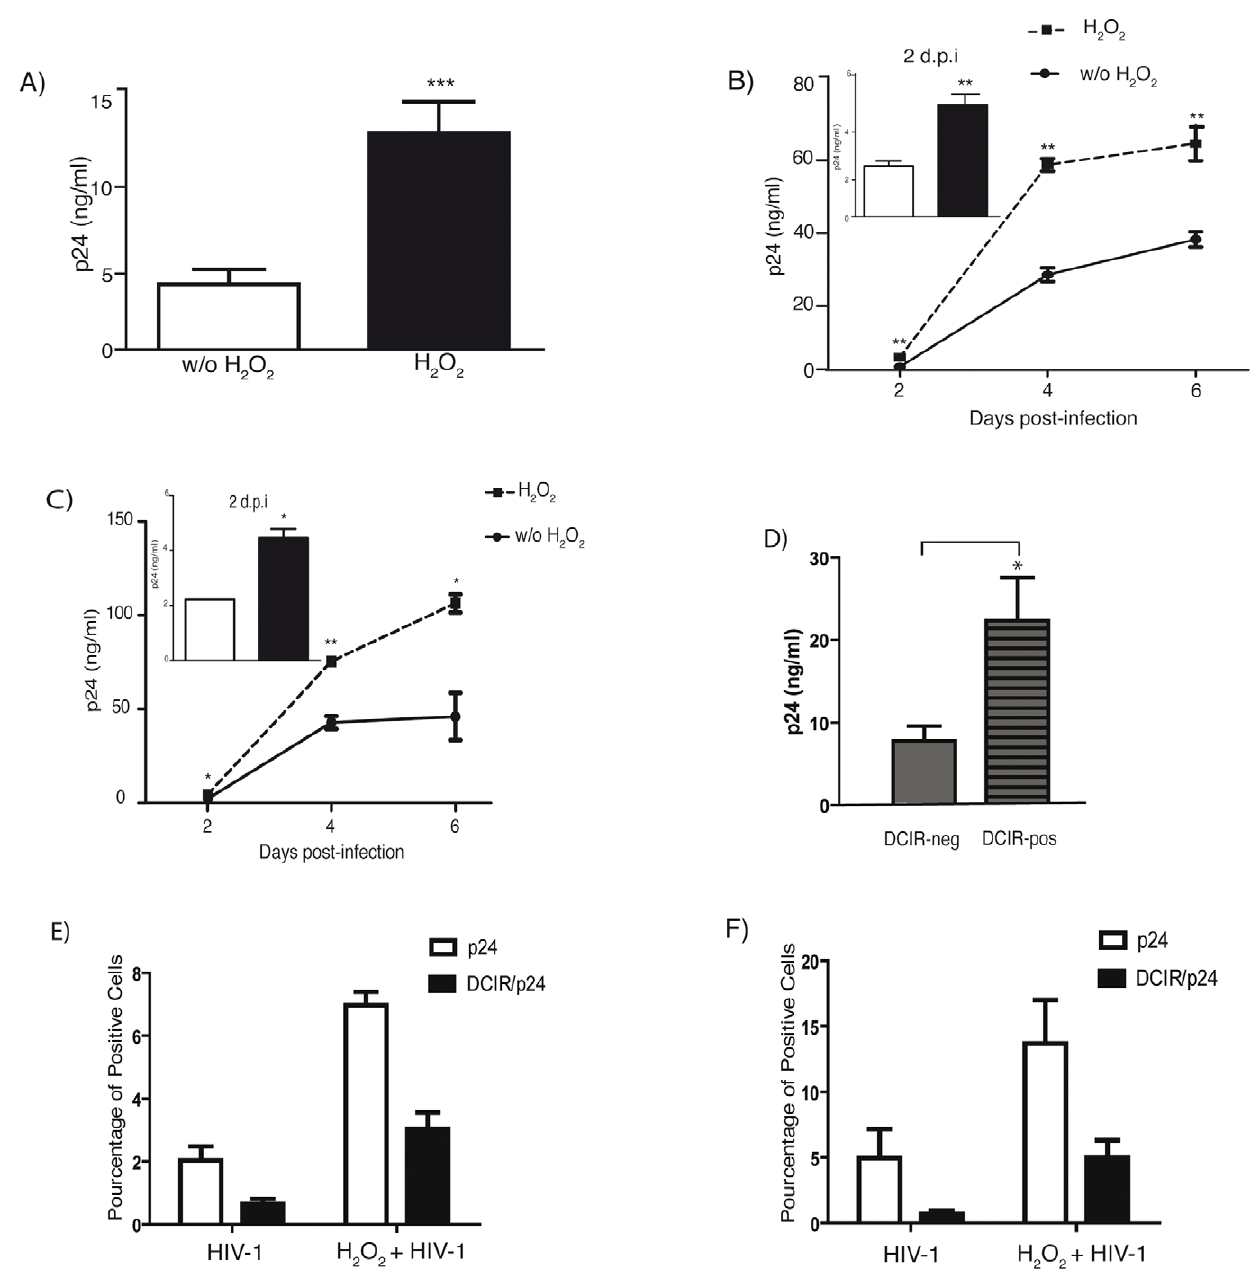
Figure 9. HIV-1 attachment/entry, replication and transfer processes are all promoted in H 2 O 2 -treated CD4 + T cells. Target CD4 + T cells (1 6 10 6 ) were treated for 16 h with H 2 O 2 (30 m M) to induce surface expression of DCIR. (A) Cells were next exposed to NL4-3 (100 ng of p24) for 1 h at 37 u C, extensively washed to remove unabsorbed virons before assessing the p24 content. (B) Cells were first incubated with NL4-3 (100 ng of p24) for 2 h at 37 u C, washed extensively to remove input virus and cultured in complete culture RPMI-1640 medium supplemented with rhIL-2 for the indicated number of days. Cell-free supernatants were collected and assayed for the p24 content. (C) Cells were exposed to NL4-3 (100 ng of p24) for 2 h at 37 u C, next washed extensively to remove input virus, and finally co-cultured with autologous CD4 + T cells in complete culture RPMI-1640 medium supplemented with rhIL-2 for the indicated number of days. Cell-free supernatants were collected and assayed for the p24 content. Virus production at day 2 is depicted in the small inserts (panels B and C). (D) Cells were exposed to NL4-3 (100 ng of p24) for 2 h at 37 u C, washed extensively to remove input virus, and maintained in complete culture medium supplemented with rhIL-2 for 3 days. Next, DCIR-negative and - positive cells (used as transmitter cells) were isolated with magnetic beads and co-cultured with uninfected CD4 + T cells (used as recipient cells). Cell- free supernatants were collected at 3 days following initiation of the co-culture and assayed for the p24 content. (E) Cells were first exposed to NL4-3 for 2 h at 37 u C. Cells were extensively washed to remove unabsorbed virions and half of the cells were used to estimate the percentage of cells positive for surface DCIR and intracellular p24. (F) The other half was maintained for 3 days in culture before assessing both DCIR and p24. Data shown represent the means 6 SD of triplicate samples and correspond to a single experiment representative of three independent experiments. Asterisks denote statistically significant data (*, P , 0.05; **, P , 0.01; ***, P , 0.001).